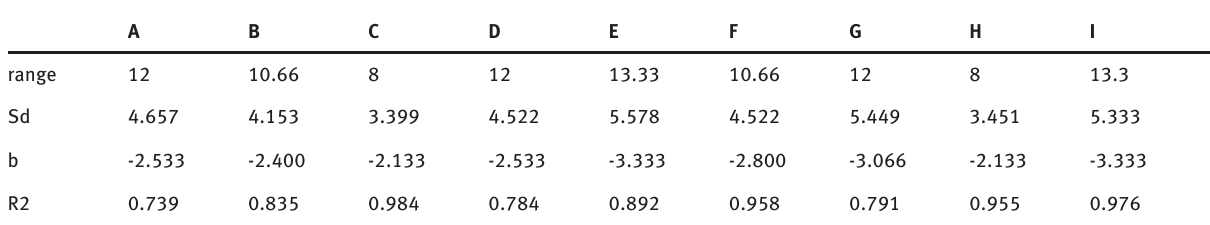
Table 3: Response of genotypes to different levels of